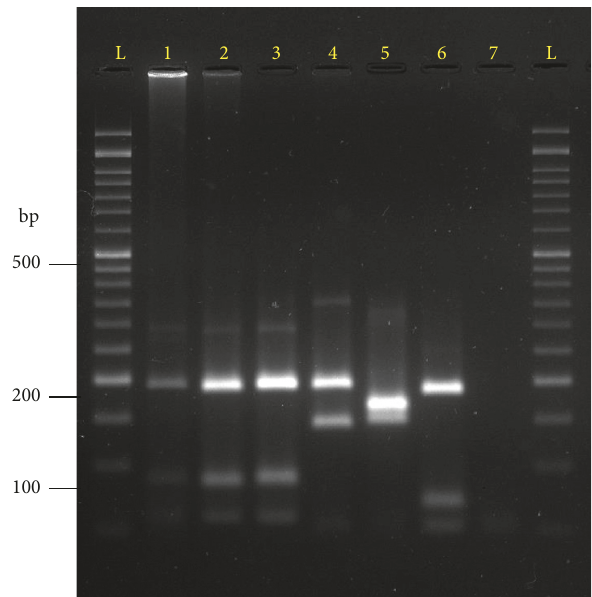
Figure 3: Restriction fragment length polymorphism (RLFP) patterns obtained from liver samples of two H . gaumeri (Hg). L, 100bp molecular weight ladder; 1, Hg1 positive to L . mexicana ; 2, Hg2 positive to L . mexicana ; 3, reference strain of L . ( L .) mexicana (MHOM/MX/2011/Lacandona); 4, reference strain of L . ( L .) amazonensis (MHOM/BR/1973/M2269); 5, reference strain of L . ( V .) braziliensis (MHOM/BR/1995/M15280); 6, reference strain of L. (L.) infantum chagasi (MHOM/BR/72/BH46); 7, negative